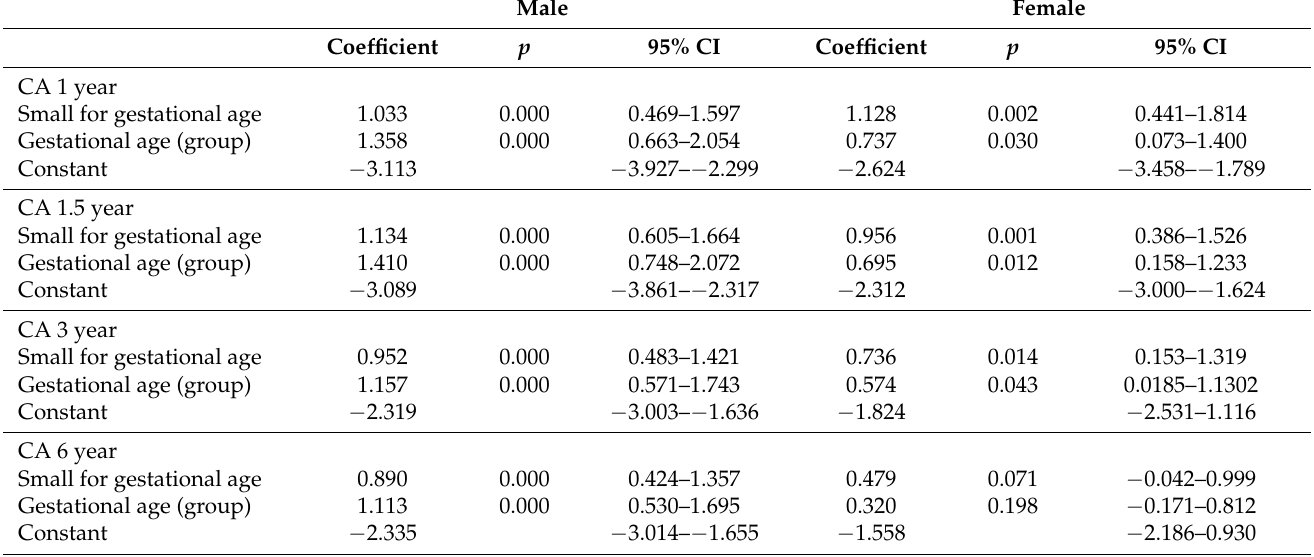
Figure 2. Z-scores trajectories (upper: male, lower: female) at 1, 1.5, 3 and 6 years corrected age in children born at less than 30 weeks of gestation. Solid lines: the 25–29 weeks groups, dotted lines: the 22–24 weeks groups. * p < 0.05, ** p < 0.01, compared with the 22–24 weeks group. Table 2. Linear regression analysis to determine the association between body weight z-scores and the presence of small for gestational age and two gestational age groups.